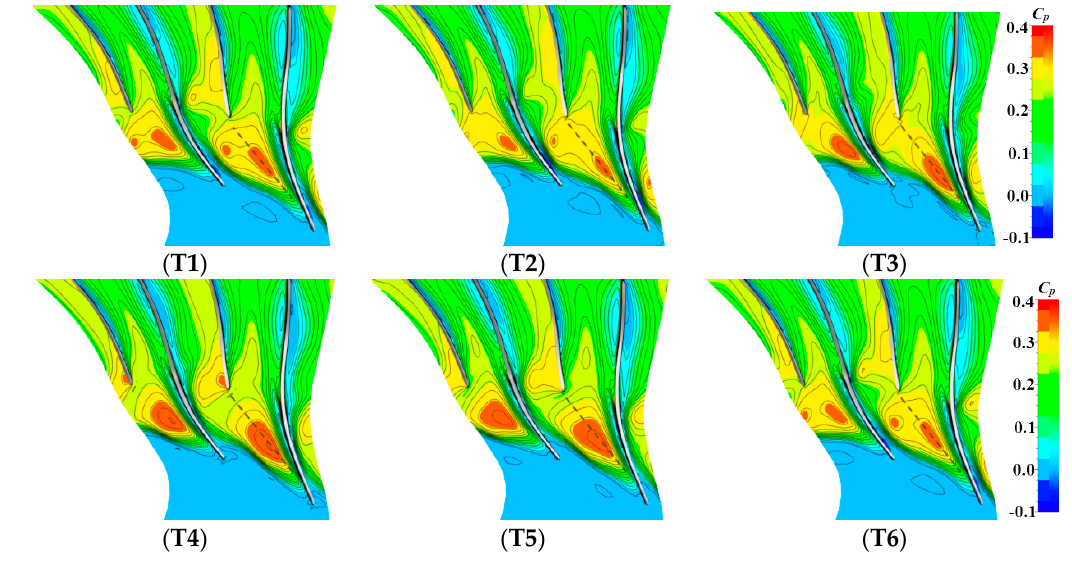
Figure 2. Variation in static pressure distribution with time.